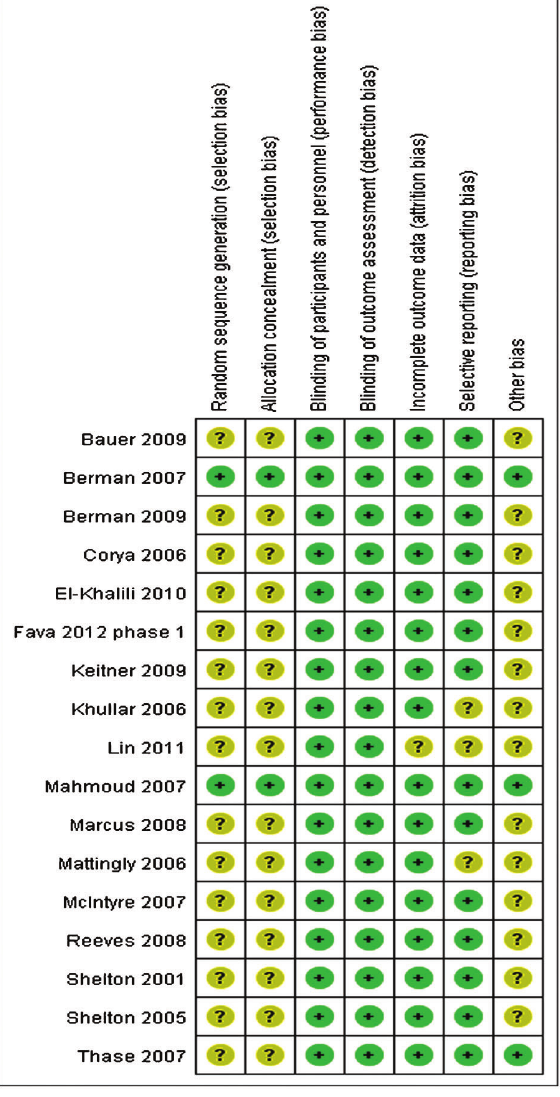
Figure 2. Assessment of risk of bias for individual trial. ‘‘?’’: unclear risk of bias; ‘‘++’’: low risk of bias. Thase et al. (29) contains two identical trials; we combined them to analyze the discontinuation